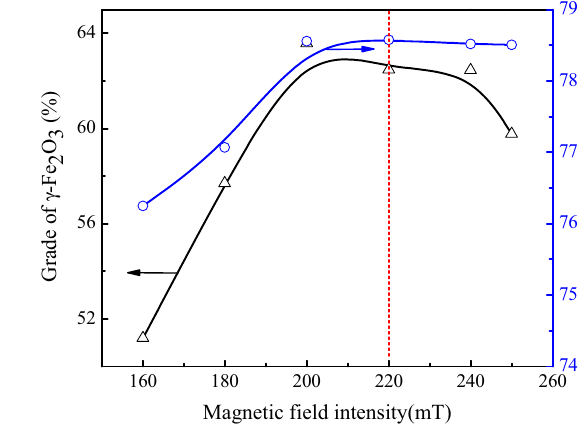
Figure 6: E ff ect of magnetic fi eld intensity on γ - Fe 2 O 3 recovery.